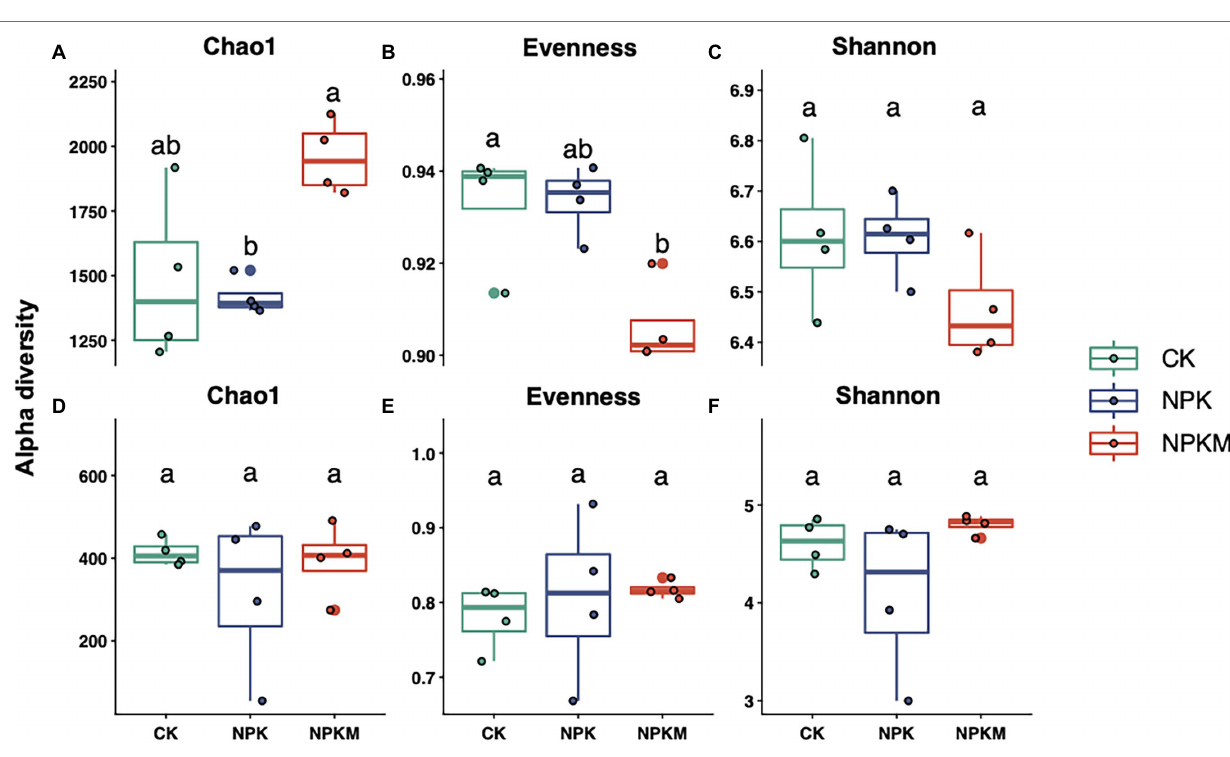
FIGURE 2 | Effects of long-term fertilization treatments on Chao1 richness, evenness, and Shannon diversity indices of (A–C) bacteria and (D–F) fungi. Different letters indicate significant differences among treatments (Tukey’s post hoc test, p < 0.05).